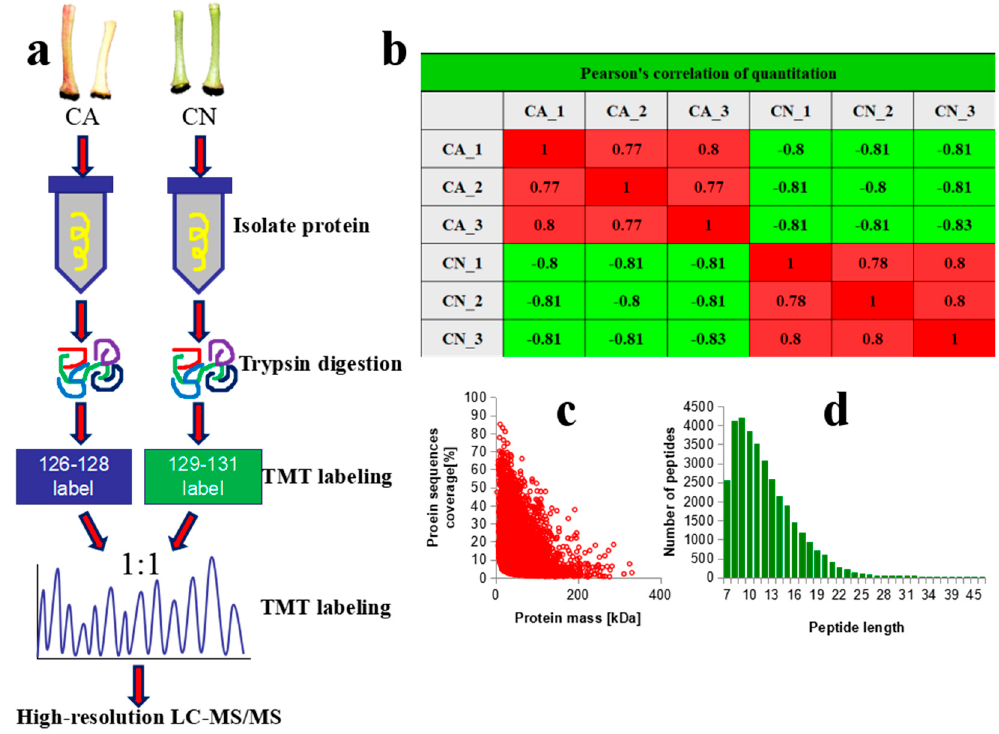
Figure 3. The trial technique for quantitative proteome investigation and quality control approval of MS information. ( a ) Protein was extricated in three natural imitates for each sample gathering. Entire protein samples were trypsin digested and dissected by HPLC-MS / MS. ( b ) Pearson s correlation of protein quantitation. ( c ) Mass delta of all identified peptides. ( d ) Length distribution of every single distinguished peptide.